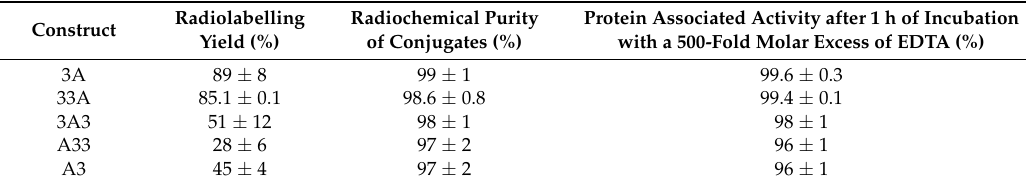
Table 2. Radiolabelling yield, radiochemical purity after purification using a NAP-5 size exclusion column, and stability on ethylenediaminetetraacetic acid (EDTA) challenge of different 111 In-labelled ABD-fused anti-HER3 affibody molecules.